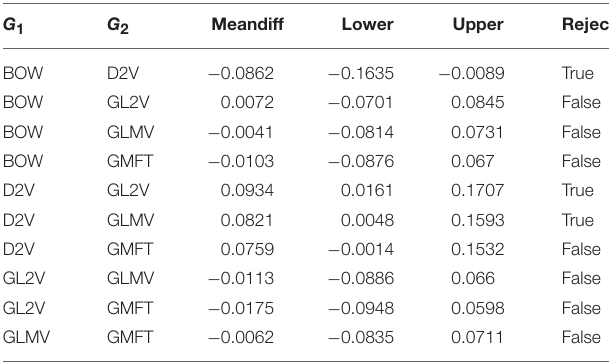
TABLE 7 | The influence of feature set through multiple comparison of means - Tukey HSD, FWER=0.05.